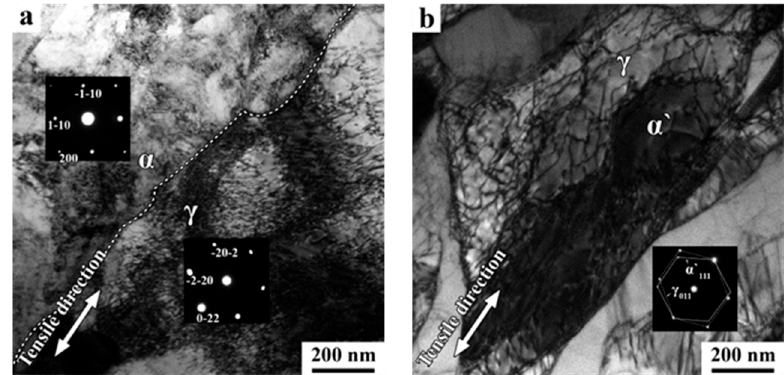
Figure 7. Representative TEM images revealing the deformed microstructures of the 700 °C annealed sample after tensile strain of 0.01: ( a ) At the phase interface between austenite and ferrite; ( b ) In the austenite phase where deformation induced martensitic transformation (DIMT) has occurred.